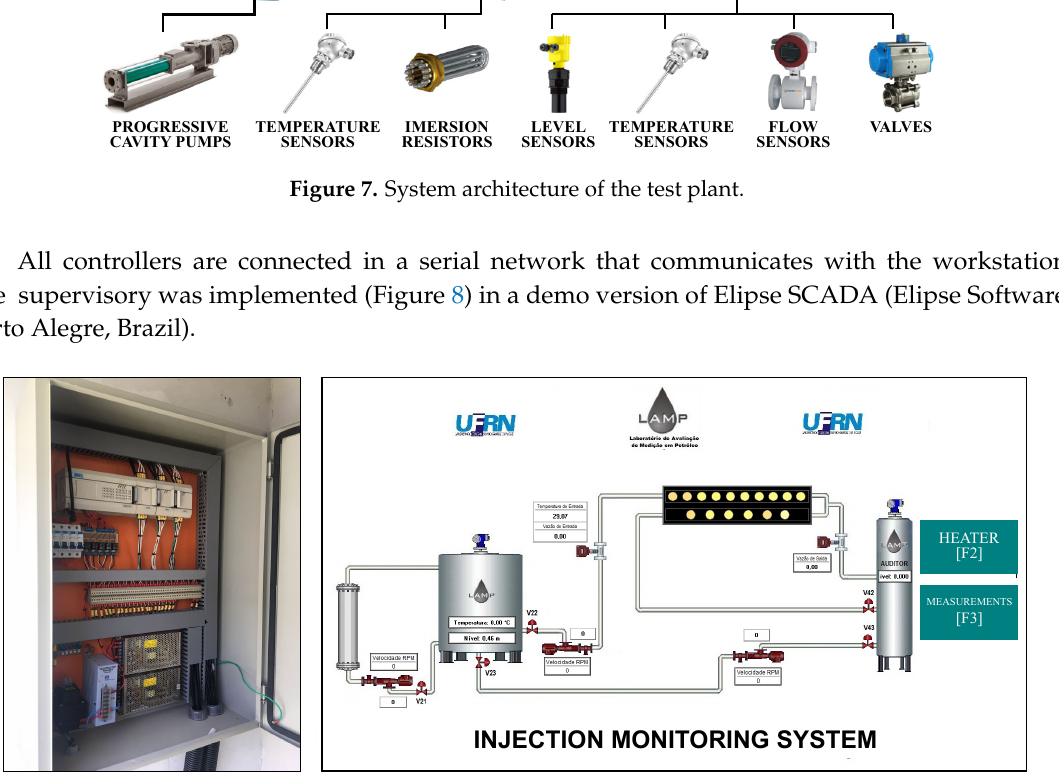
Figure 8. ( a ) Command panel of the PLC WEG TPW03. ( b ) Principal screen of the supervisory